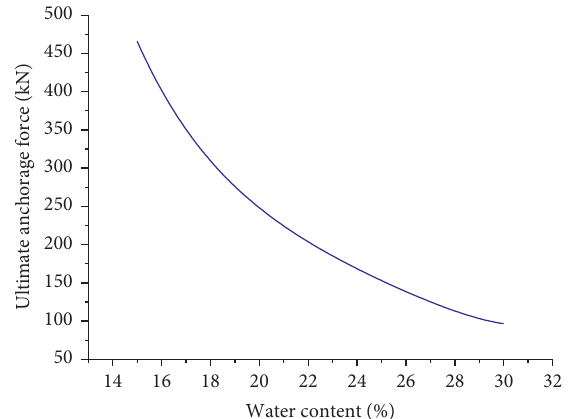
Figure 18: Relationship diagram of limiting anchorage force with water